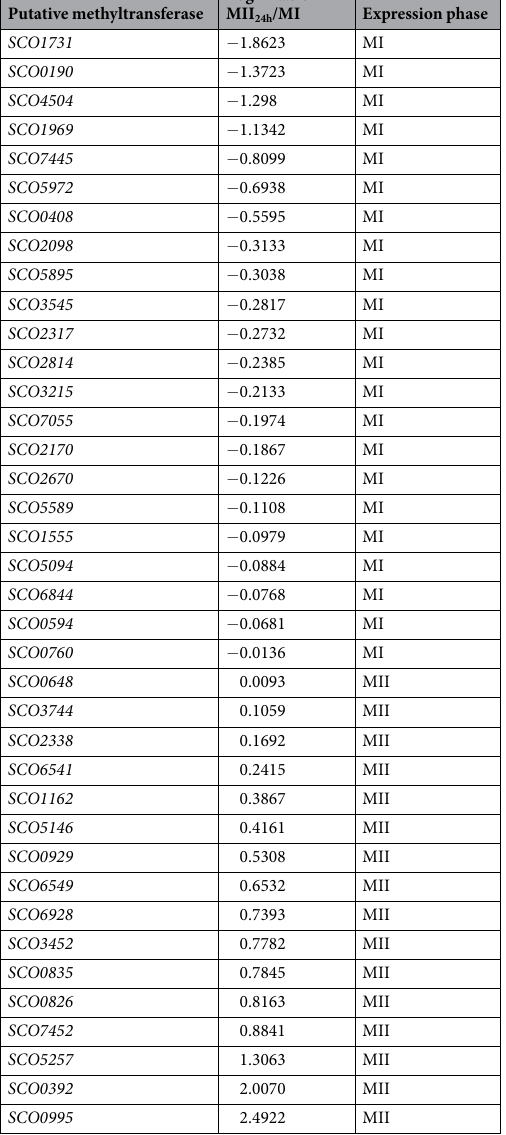
Table 1. List of putative methyltransferases annotated in S. coelicolor genome (StrepDB - The Streptomyces Annotation Server). Ratios of log 2 of gene expression between MII24 h/MI are reported. A negative ratio indicates that the gene is more transcribed in MI, a positive one that is more transcribed in MII 24 h. The ratios were taken from Yagüe et al . 29